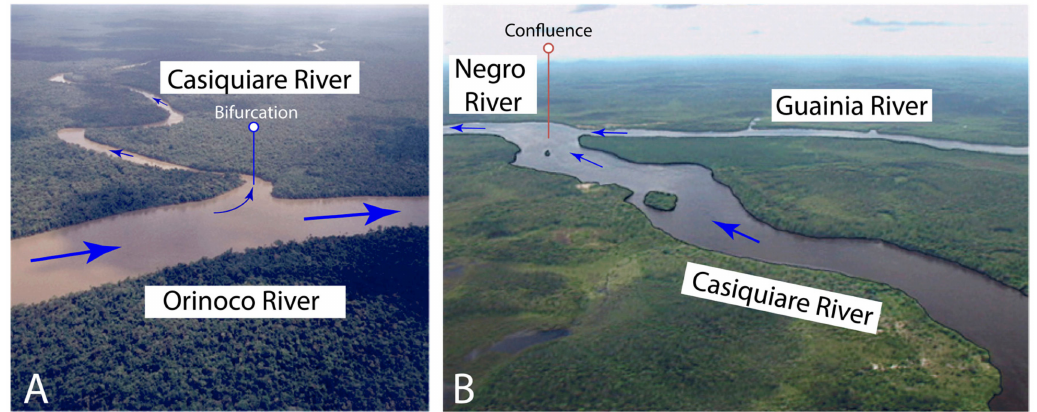
Figure 4. Aerial photos of the bifurcation ( A ) and confluence ( B ) taken from a helicopter by A. Laraque on September 10,